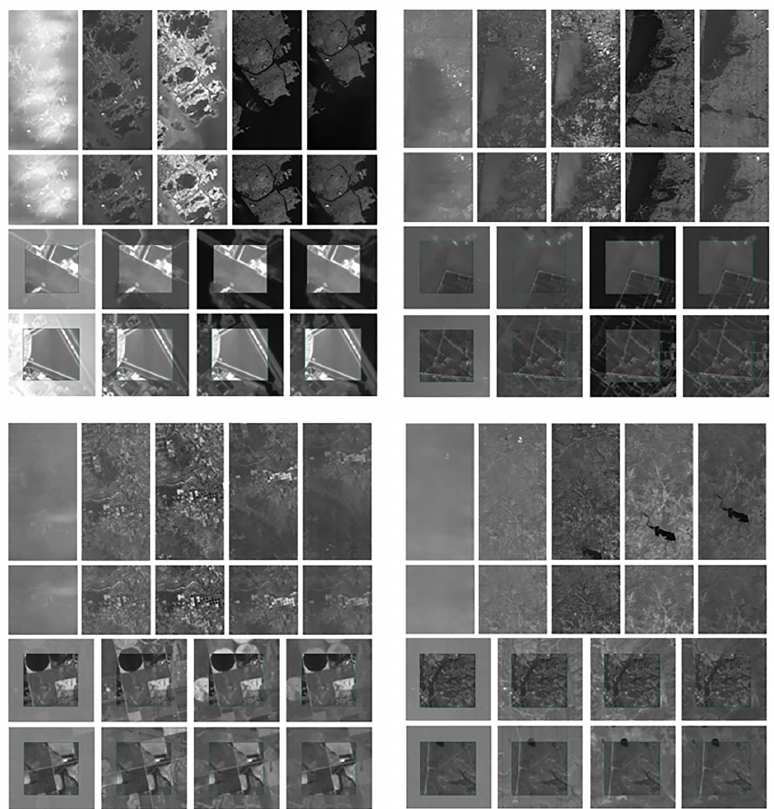
Figure 8. Interband registration results between four sets of hyperspectral image. In each set result, the first row from left to right shows the 1st, 8th, 15th, 24th, and 32nd bands of the original images of the hyperspectral images; the second row shows the registered and cropped images; the third row and the fourth row show the registration details of the 1st, 8th, 24th, and 32nd bands relative to the target image (the 15th band). A scene with unique features is selected and magnified to the pixel level to show the registration accuracy. The target image is inside, and the original image is outside the rectangular